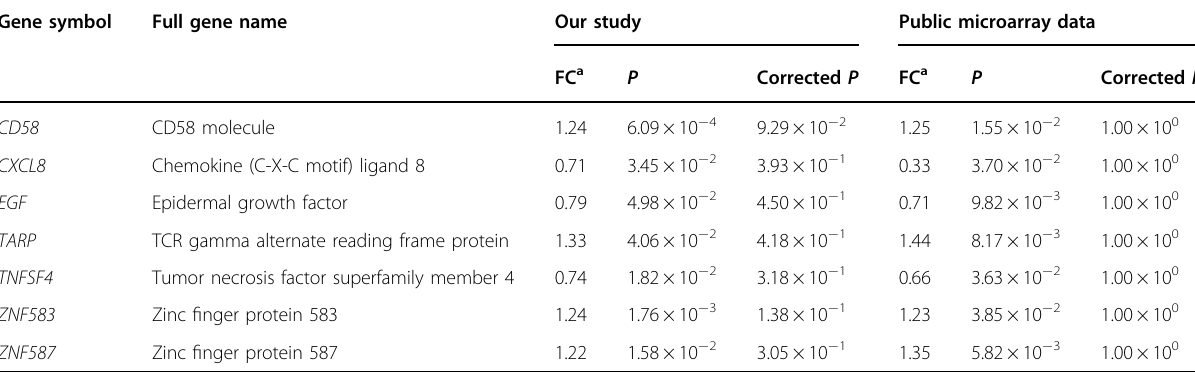
Table 2 Differentially expressed genes in major depressive disorder patients compared to healthy controls in our data and public microarray data